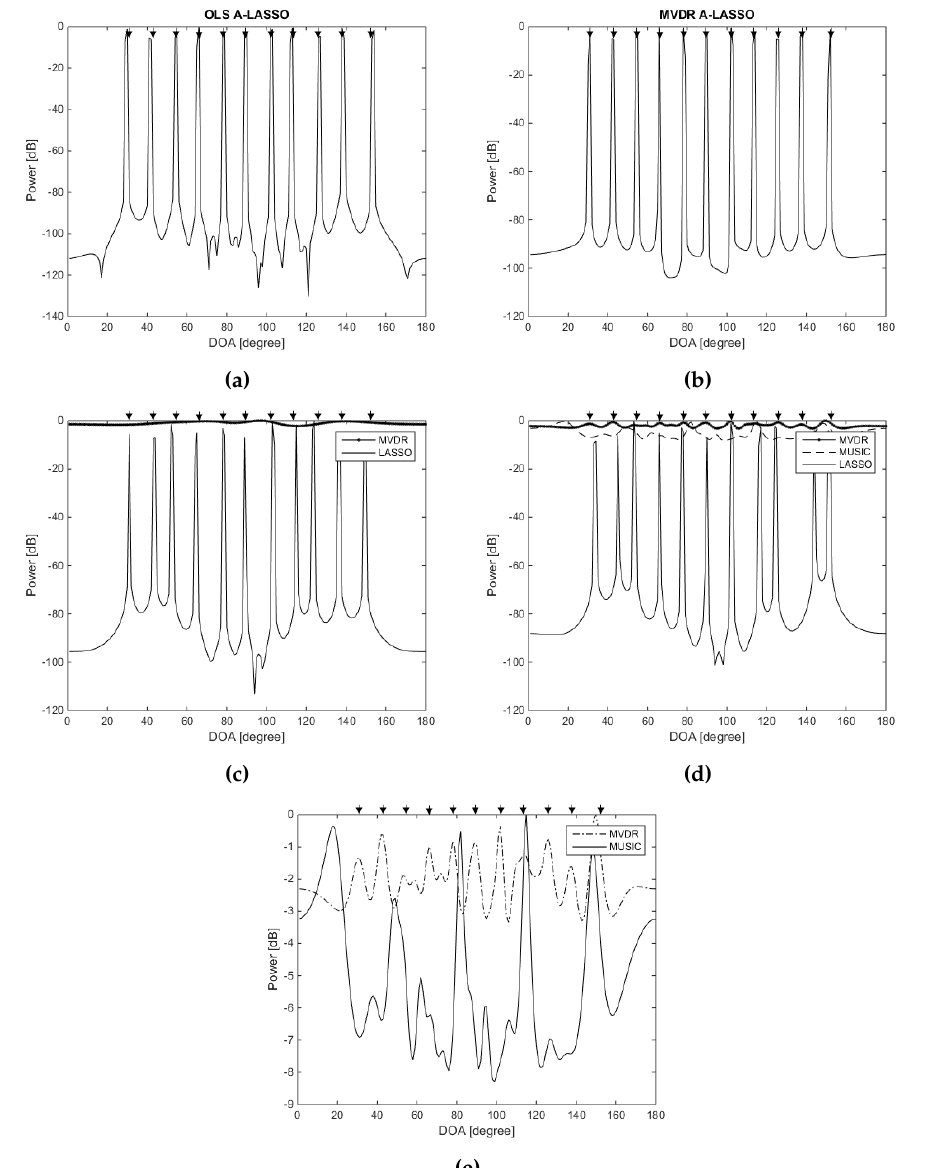
Figure 8. DOA estimation when the number of sources is more than the number of sensors: ( a ) After one iteration of OLS A-LASSO; ( b ) After one iteration of MVDR A-LASSO; ( c ) Classical LASSO and MVDR using a six-element array; ( d ) Classical LASSO, MVDR and MUSIC using a 23-element array; ( e ) MVDR and MUSIC using a 23-element